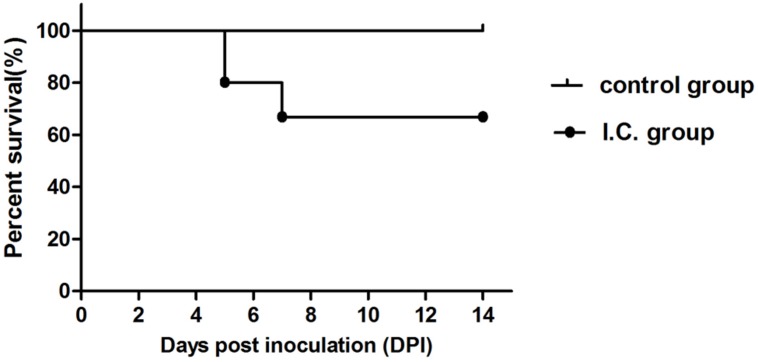
The survival rate of Kunming mice infected with TMUV by i.c. At 5 dpi, three mice died in the i.c. group. At 7 dpi, two mice died in the i.c. group.